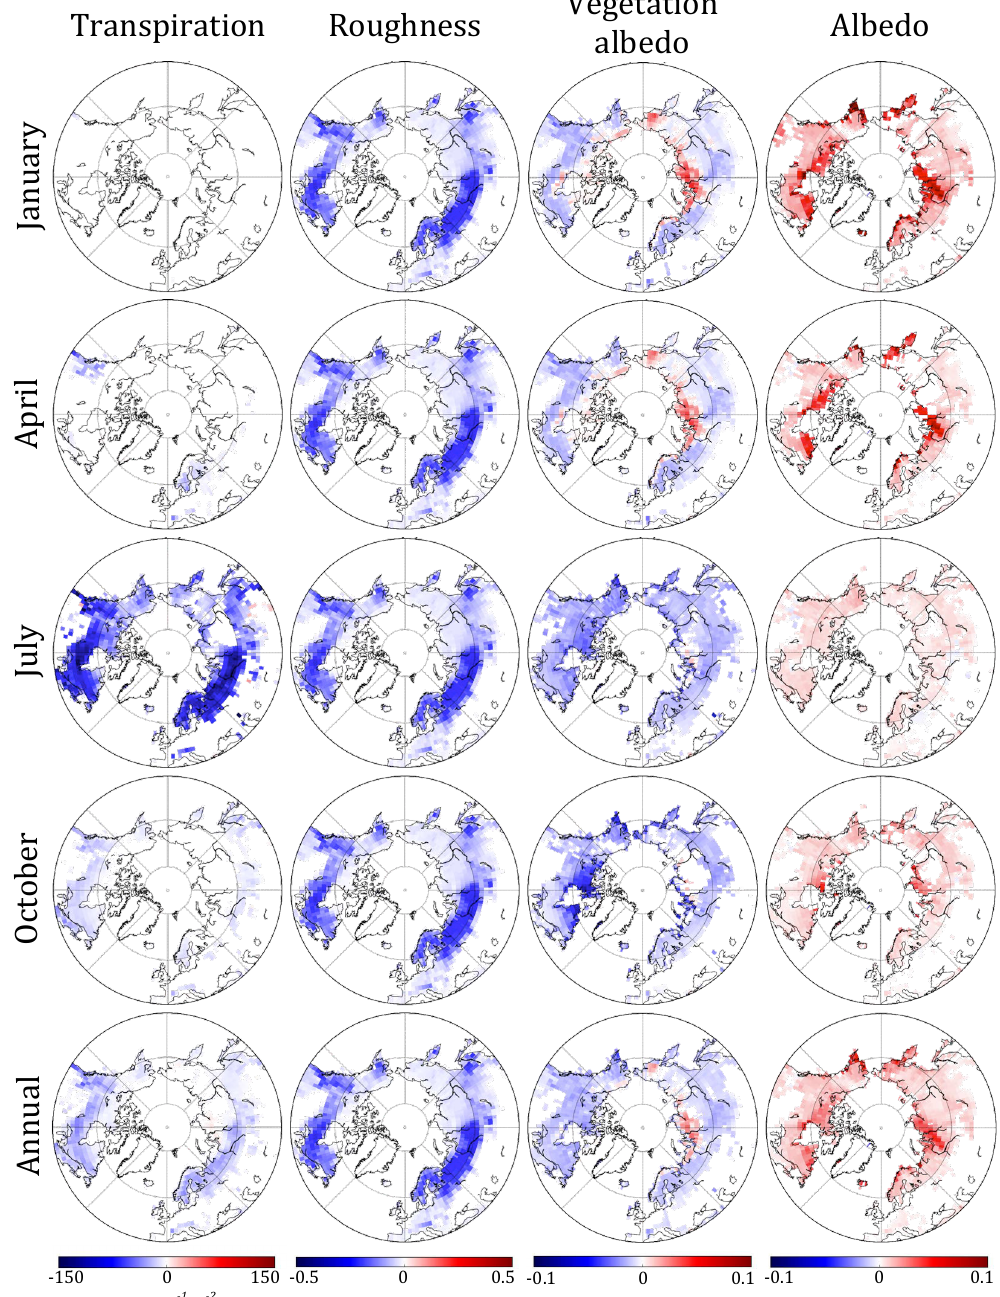
Figure 12. Maps of the significant differences ( p value = 0.05) between the simulation with 16 PFTs (ORC16 with new boreal PFTs) and the simulation with 13 PFTs (ORC13 standard version), for albedo (total albedo and vegetation only without snow and bare soil contribution), roughness and transpiration for January, April, July, October, and the annual mean (mean over the period 2004 to 2013).